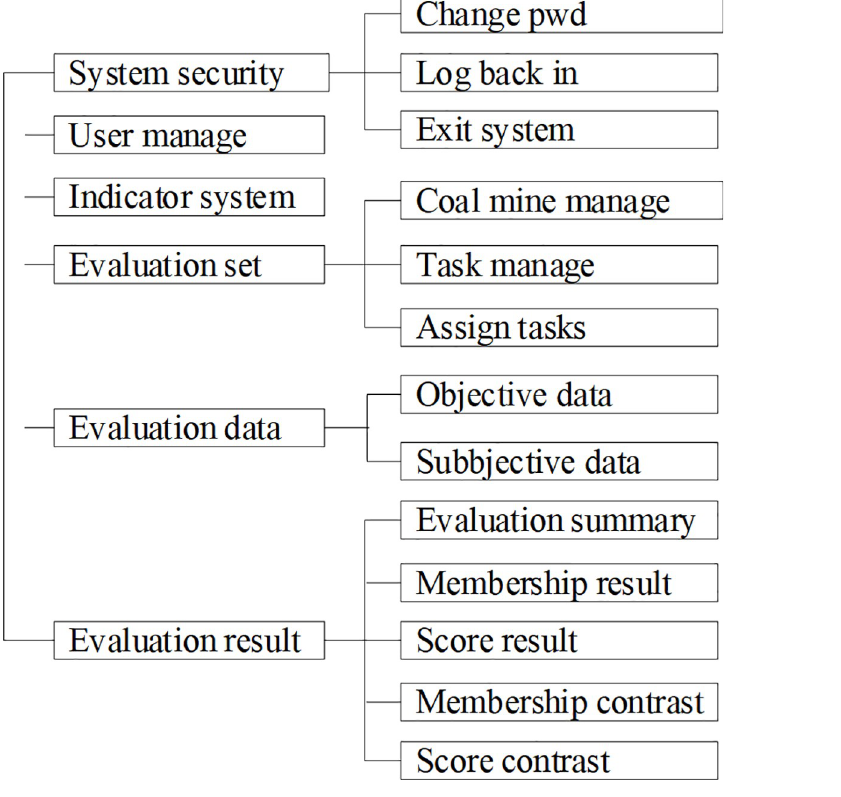
Fig 3. Function modules of Group